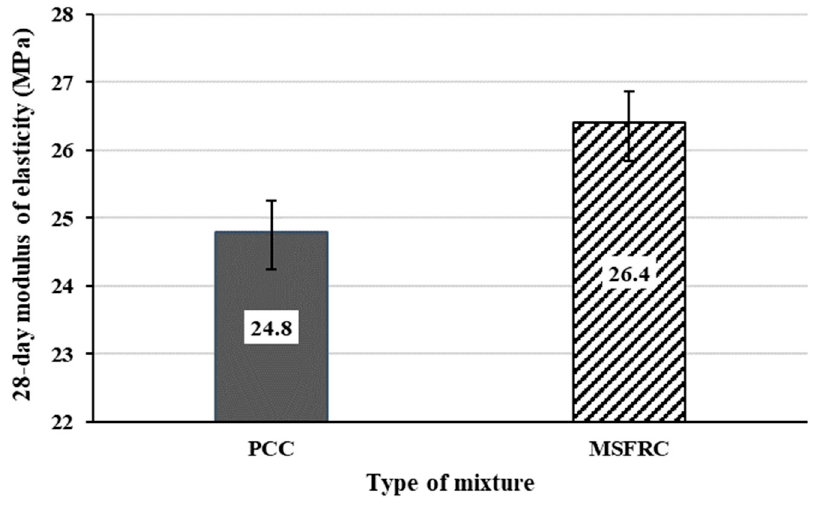
Figure 11. Modulus of elasticity test results.